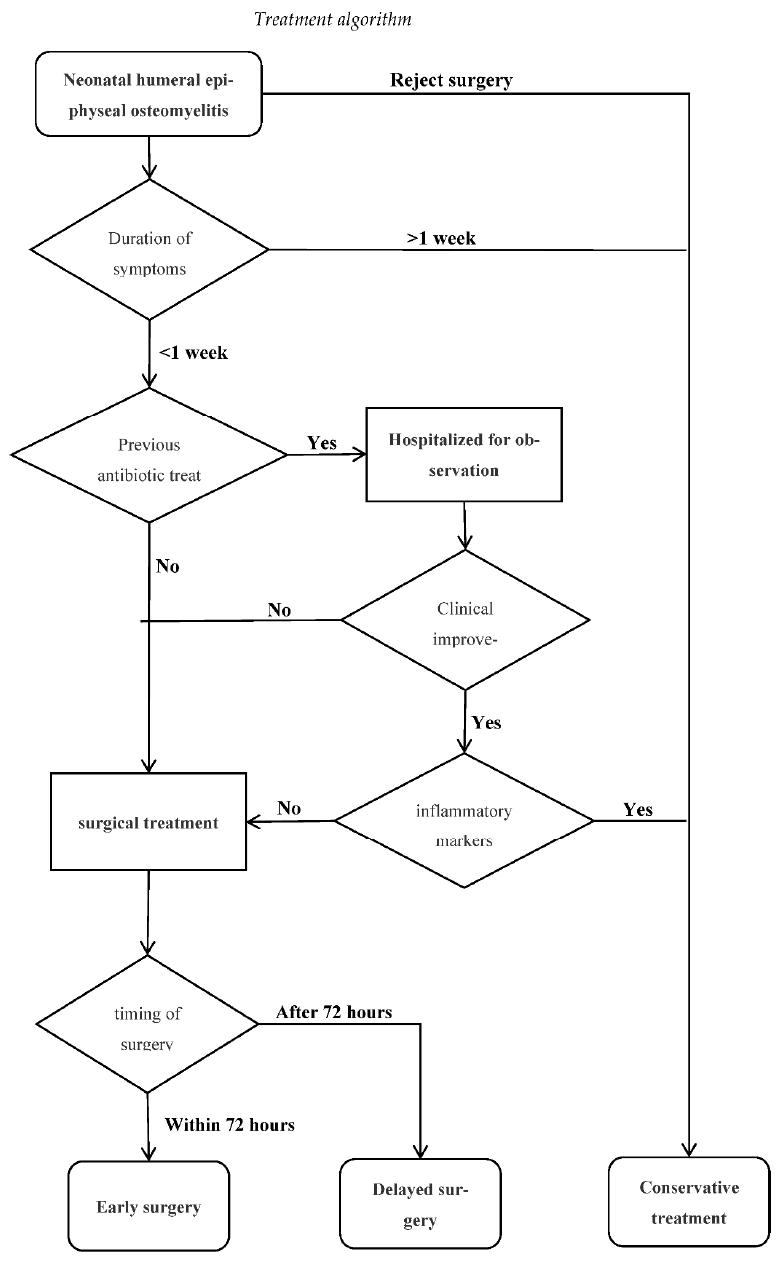
Figure 1. Diagnostic algorithm.